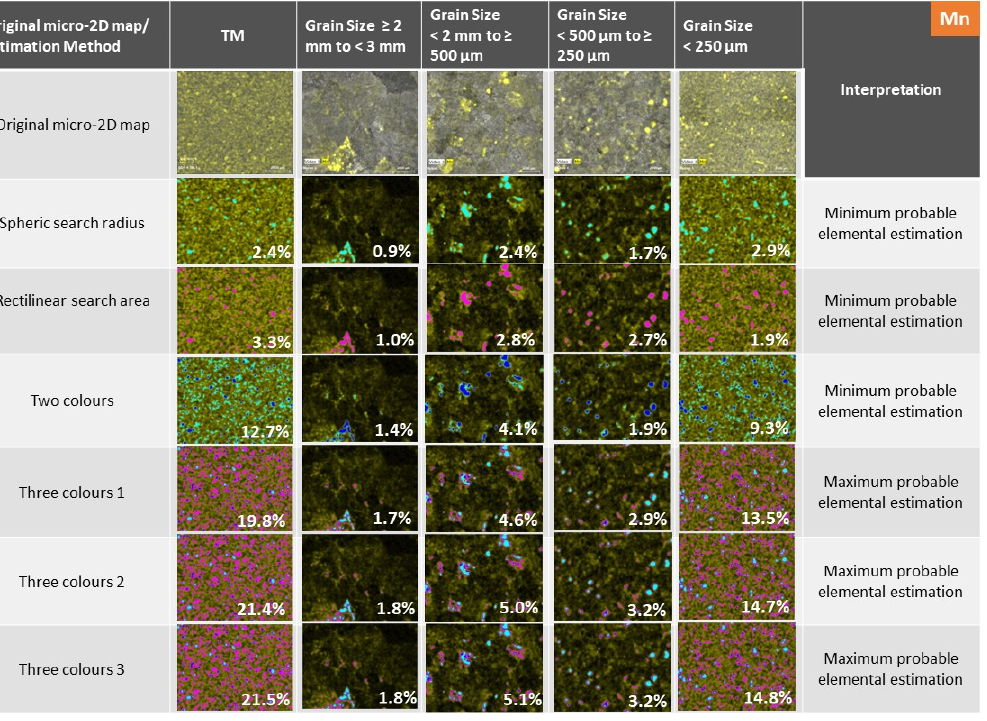
Figure A2. Minimum and maximum probable elemental occurrence in µ-XRF 2D map (percentage of area %) for Mn.